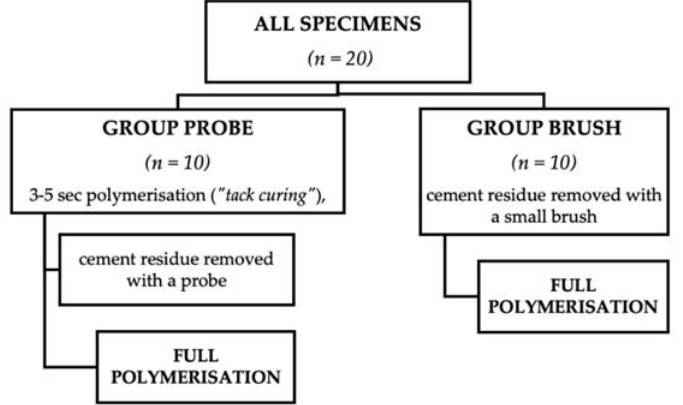
Figure 3. The study groups with the cementation and two different cement removal techniques.